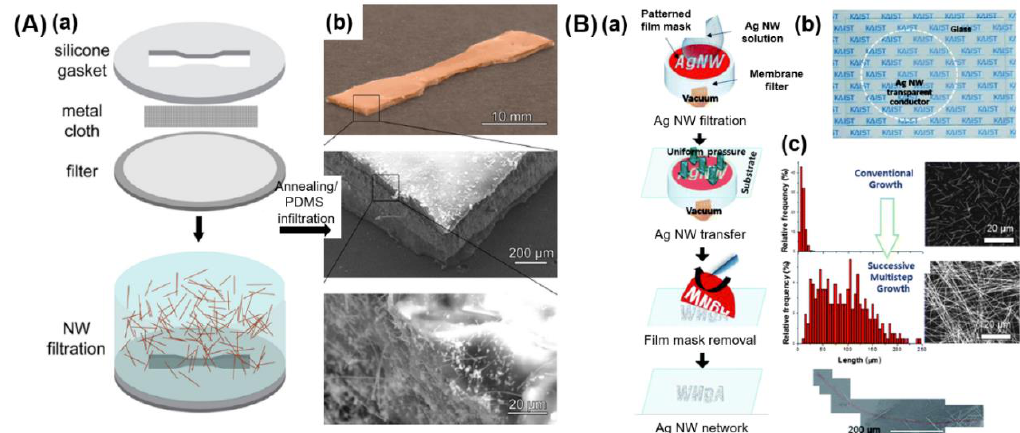
Figure 5. ( A ) Stretchable conductive composites of Cu − Ag NW felt. ( a ) Cu − Ag NWs filtered through a silicon gasket onto a metal cloth to create a NW felt in the shape of the hole in the gasket. ( b ) Photograph and SEM image of Ag NW felt after annealing and PDMS infiltration. Reproduced with permission from [17]. Copyright 2018 American Chemical Society. ( B ) ( a ) Scheme of Ag NW flexible TCE by successive multistep growth (SMG) process. ( b ) Photograph of Ag NW electrode on a glass substrate. ( c ) Ag NW length distribution and corresponding SEM images of Ag NWs of different lengths. Reproduced with permission from [18]. Copyright 2012 Royal Society of Chemistry.